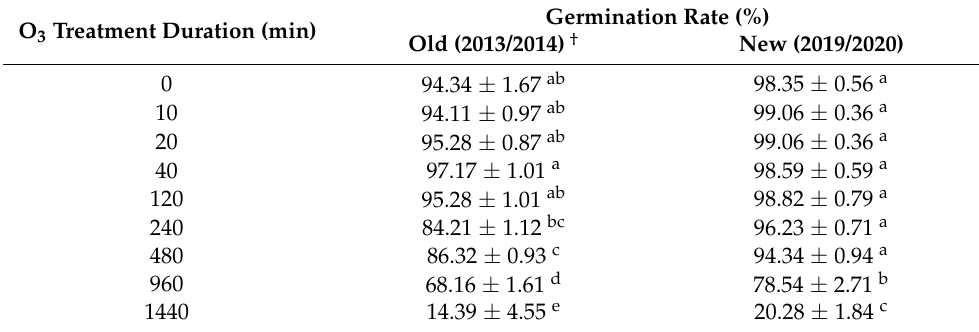
Table 3. Effect of O 3 duration at 700 ppm on the germination rate of old harvest and newly harvest barley